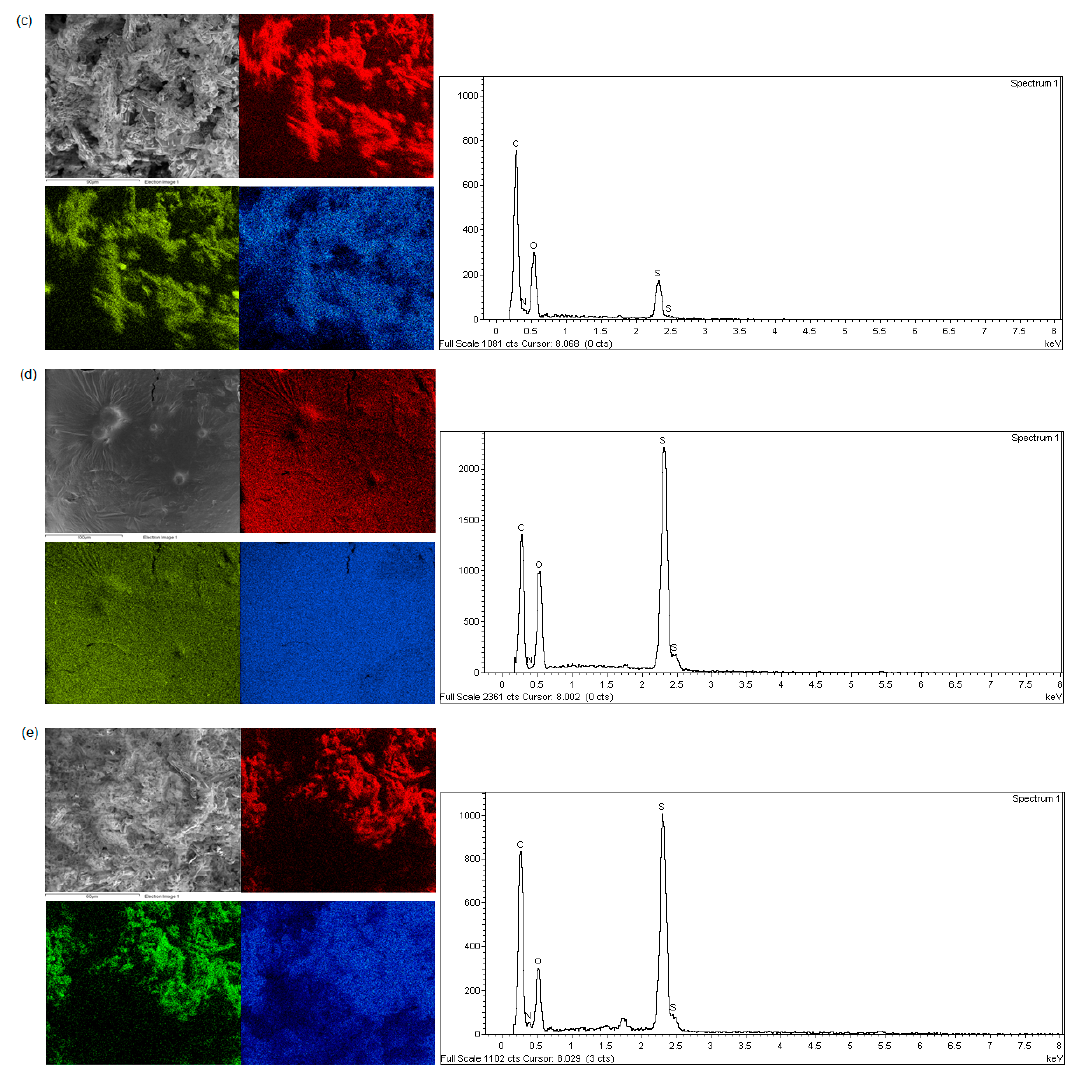
Figure 5. SEM micrographs, EDX, and elemental mapping for carbon (red), oxygen (green), and sulphur (blue) of polymer ( a ) P10, ( b ) P15, ( c ) P21, ( d ) P25, and ( e ) P51.